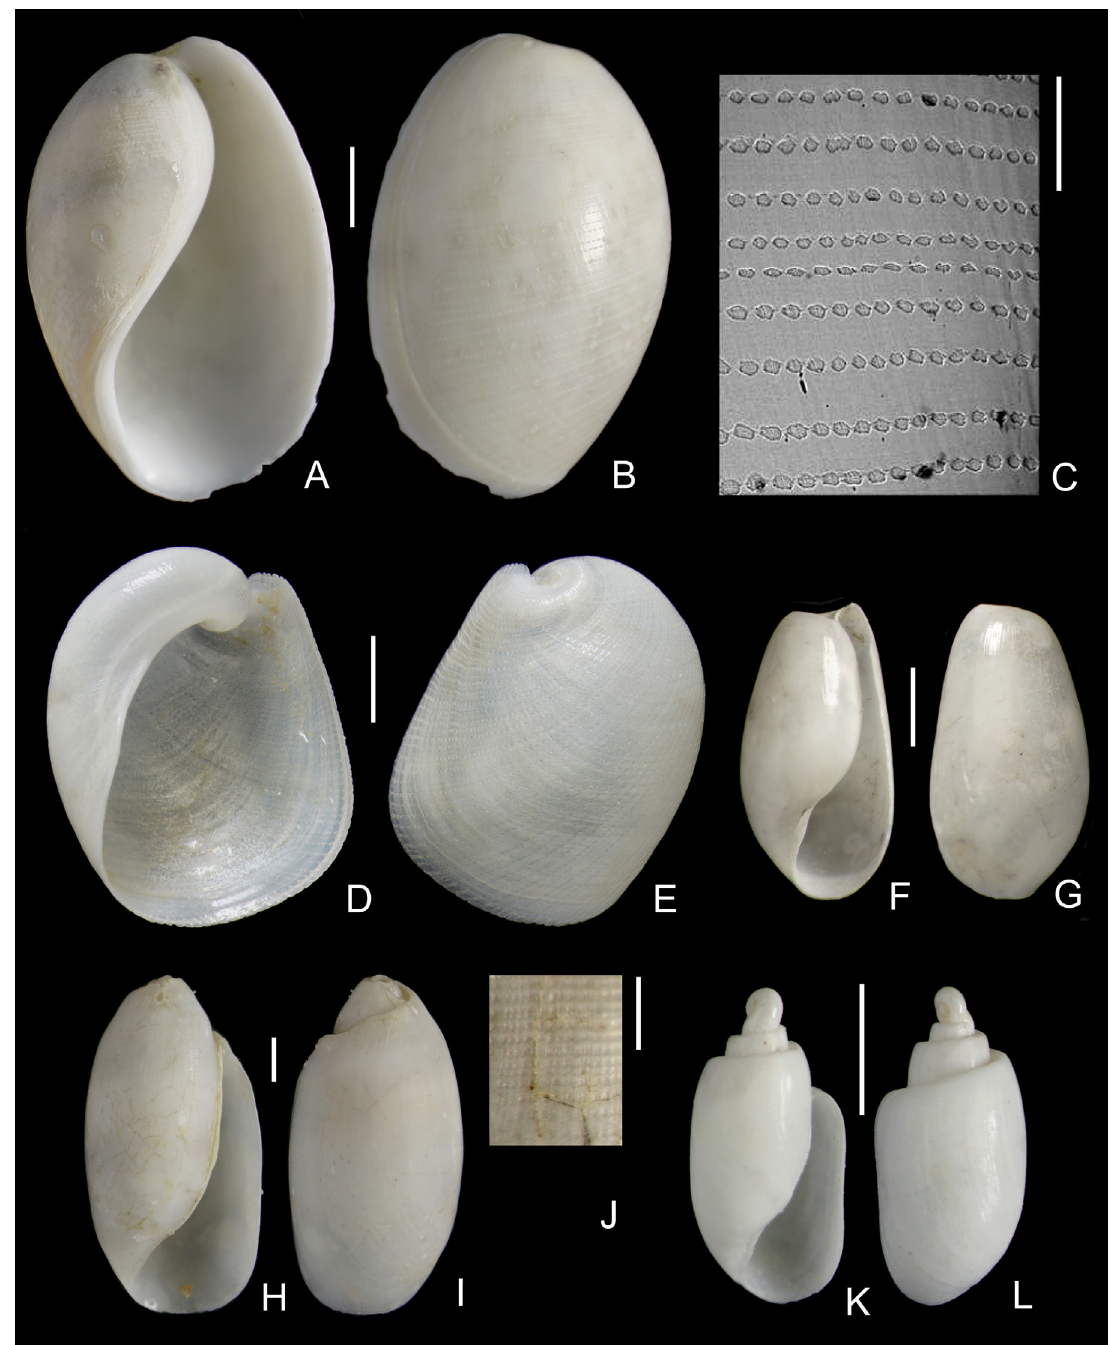
Fig. 30. Heterobranchia 3 (Scaphandridae, Philinidae, Retusidae). A–B . Scaphander punctostriatus (Mighels & C.B. Adams, 1842), BANGAL 0711, V2, 1706 m. 5.8 mm. C . S. punctostriatus , SEM micrograph of the sculpture of the body whorl, BANGAL 0711, V5, 1631 m. D–E . Laona quadrata (Wood, 1839), BANGAL 0711, V5, 4.4 mm. F–G . Pyrunculus ovatus (Jeffreys, 1871), BANGAL 0711, V5, 3.8 mm. H–I . Cylichnium oliviforme (Watson, 1883), BANGAL 0711, V10, 1720 m, 7.6 mm. J . Same specimen, detail of microsculpture of last whorl. K–L . Acteocina interrogens Gofas & Luque sp. nov., holotype (MNCN 15.05/200141H), BANGAL 0711, V4, 744 m, 2.4 mm. Scale bars: A–B, D–I, K–L = 1 mm; C, J = 200